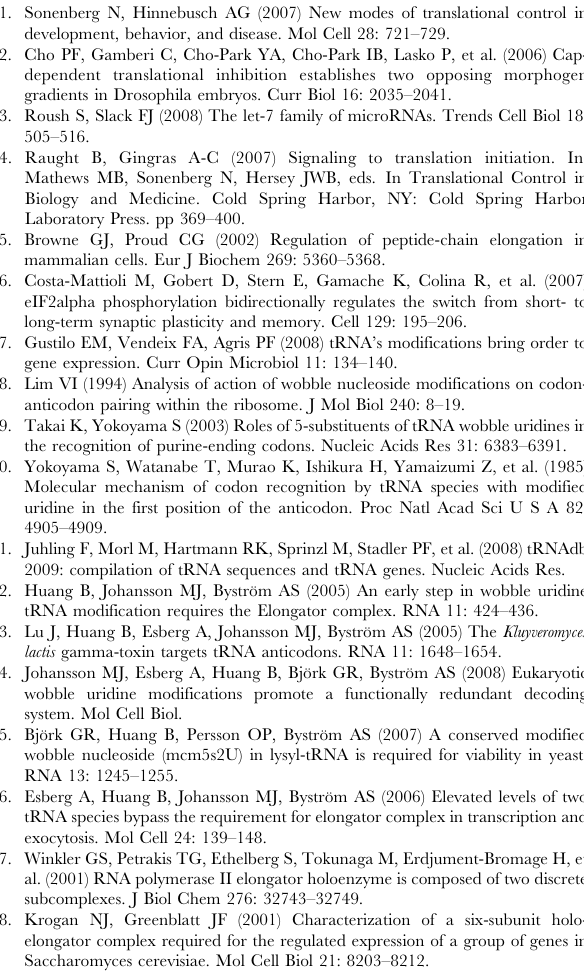
Figure S11 ELPC-1::GFP is expressed during vulval cell fate specification. Micrographs of an L3 hermaphrodite worm of the genotype elpc-1(tm2149) ; svEx557 [P elpc-1 ::elpc-1::gfp ] viewed with either Nomarski differential contrast (DIC) (A) or fluorescence (B) optics. The arrows denote the six descendants of P5.p, P6.p and P7.p. Found at: doi:10.1371/journal.pgen.1000561.s011 (1.58 MB